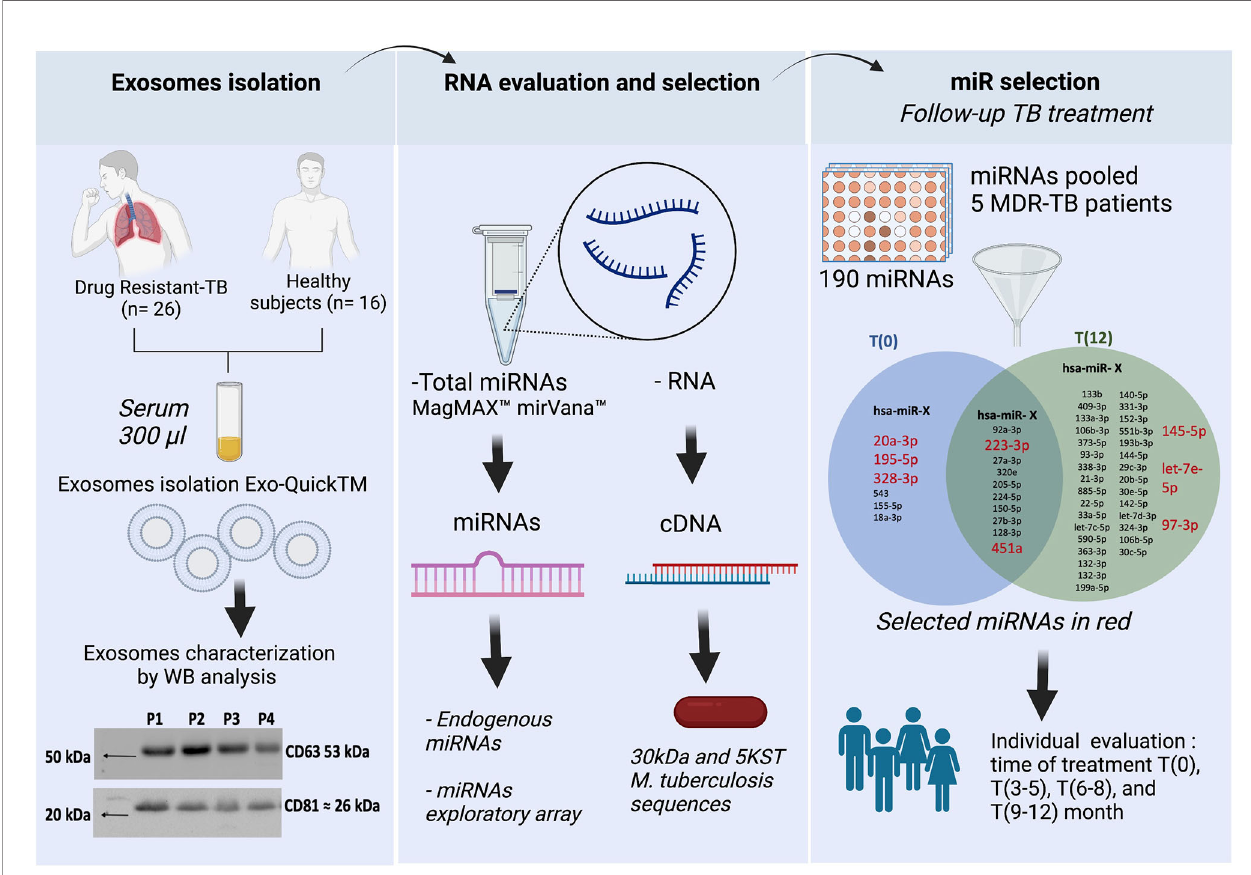
FIGURE 1 | Work fl ow chart. General strategy in three steps. First step, the exosomes isolation and characterization showed CD63 and CD81 tetraspanin expression in serum exosomes from DR-TB patients. Second step, extraction of both host-miRNAs and M. tuberculosis -RNA. Third step, miRNAs differentially expressed in serum exosomes from MDR-TB patients at T(0) and T(12). In red, the 8 miRNAs selected for individual analysis. BioRender, publication and licensing rights